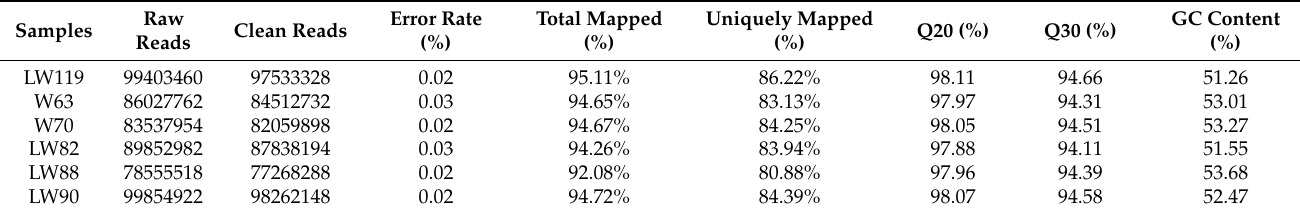
Table 2. Output statistics of sequencing